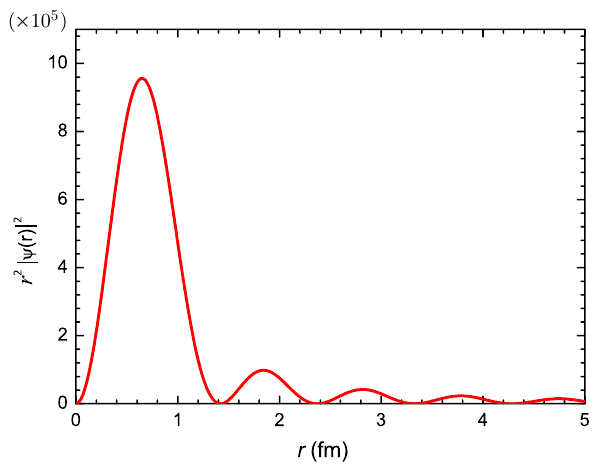
Fig. 3 The function r 2 | (cid:22)( r ) | 2 corresponding to channel (cid:7) b